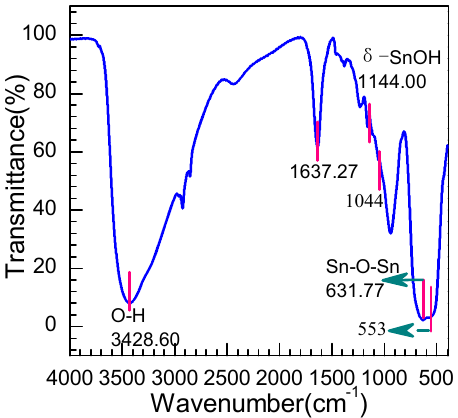
Figure 7. FT-IR spectrum of the as-prepared SnO 2 nanosheets.